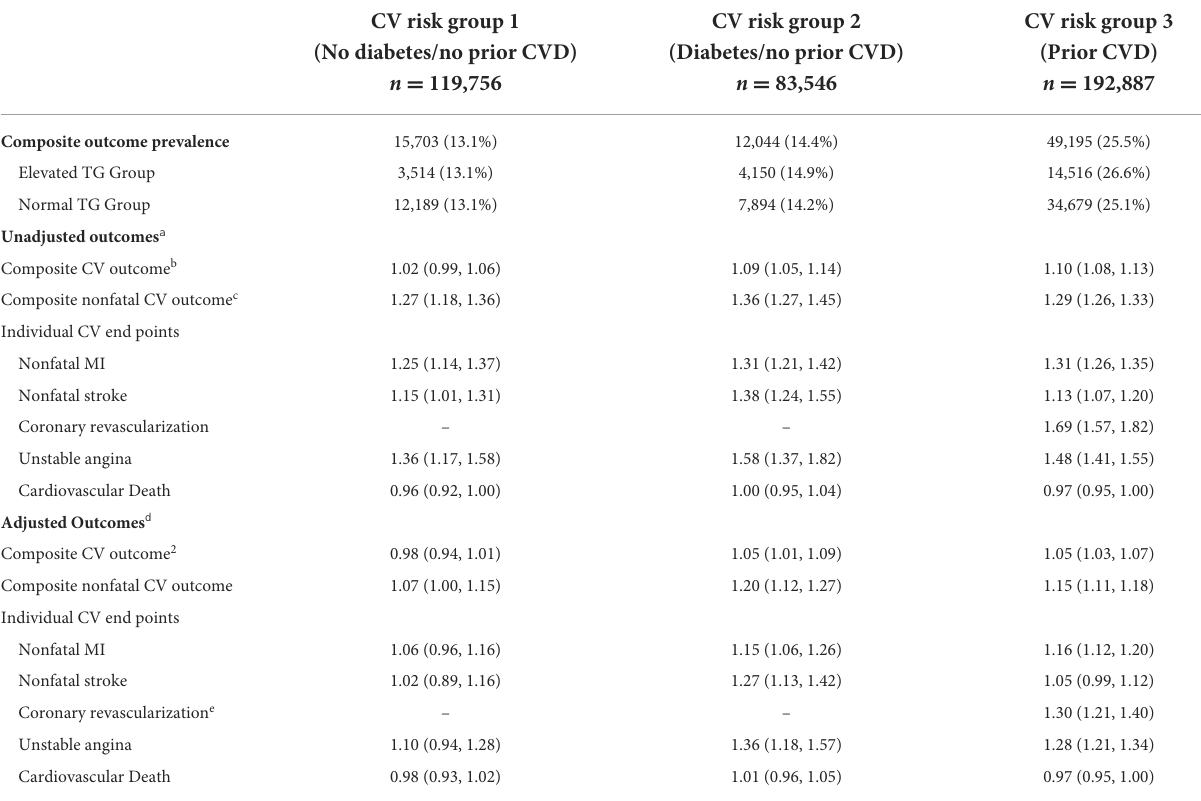
TABLE 4 Crude and adjusted rate ratios (95% confidence intervals) for elevated vs. normal TG comparisons of cardiovascular outcomes, stratified by cardiovascular risk